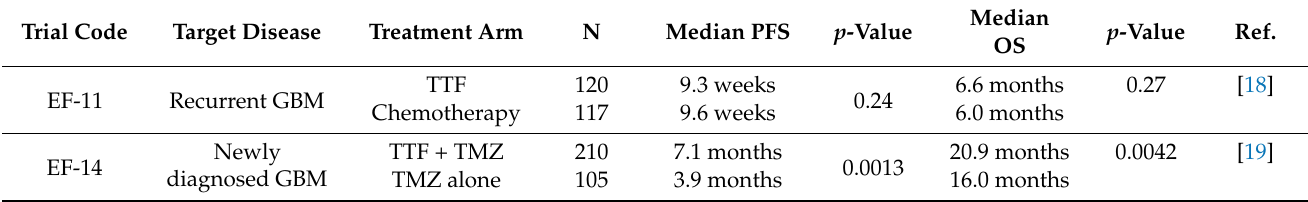
Table 1. Summary of efficacy results in pivotal trials of TTFields therapy. Trial Code Target